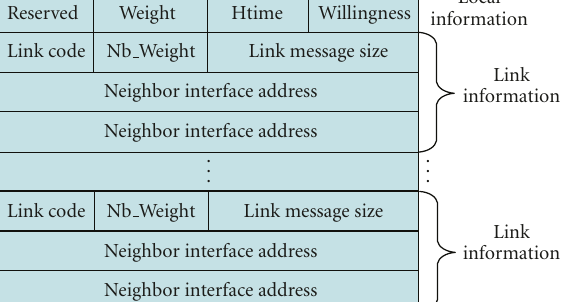
Table 1: Ns-2 simulation